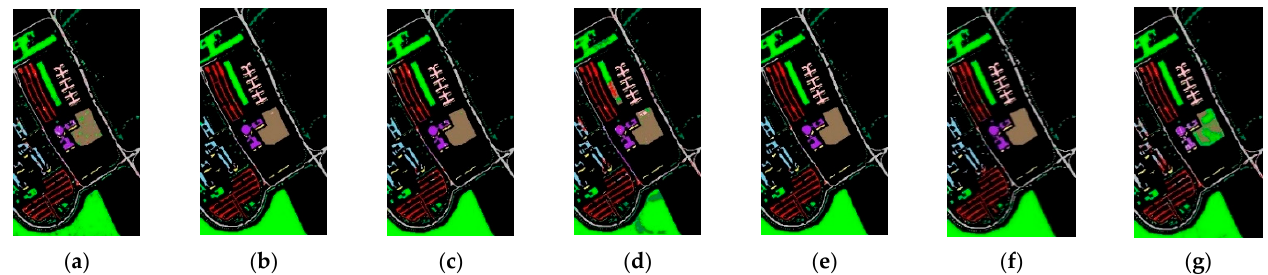
Figure 6. Feature maps achieved by using different classifiers and features for the Pavia University dataset. ( a ) DT—fusion feature; ( b ) KNN—fusion feature; ( c ) LR—fusion feature; ( d ) NBM—fusion feature; ( e ) SVM—fusion feature; ( f ) SVM— spatial feature; and ( g ) SVM—spectral